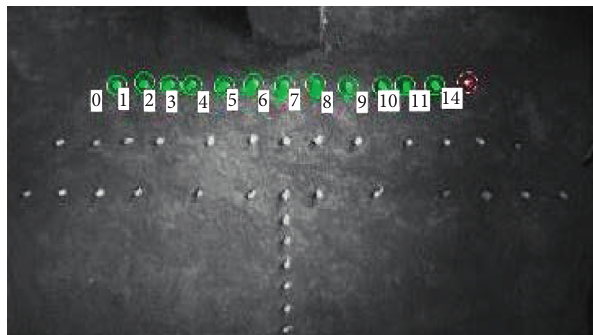
Figure 7: Example of gauge points.